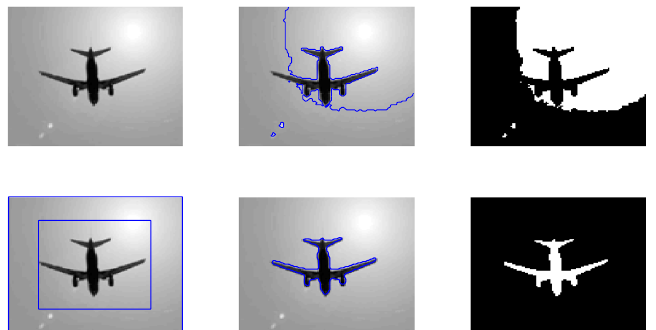
Figure 10. As Bregman-split method is well known for its speed. But it can be seen that the performance of our proposed model is better than Goldstein et al. 37 . The first row is the segmentation result of Goldstein et al. 37 and second row is the segmentation result of our proposed model with p = 0.5 , µ = 0.7, and σ = 0.6.